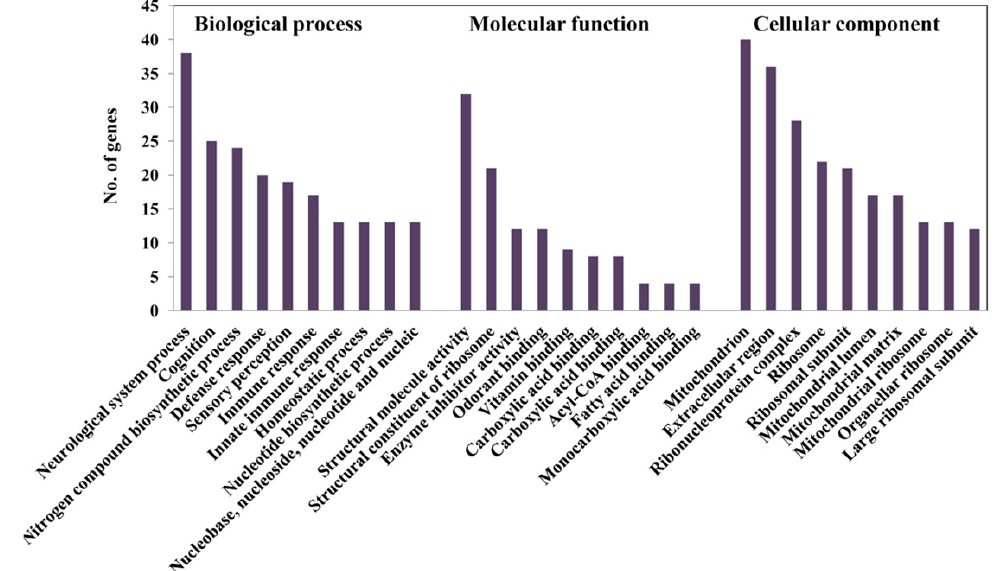
Figure 7. Gene Ontology (GO) analysis of expressed genes showing log 2 fold changes between control diet (CD) and high fat diet (HFD). GO terms in the biological process, molecular function, and cellular component were shown.